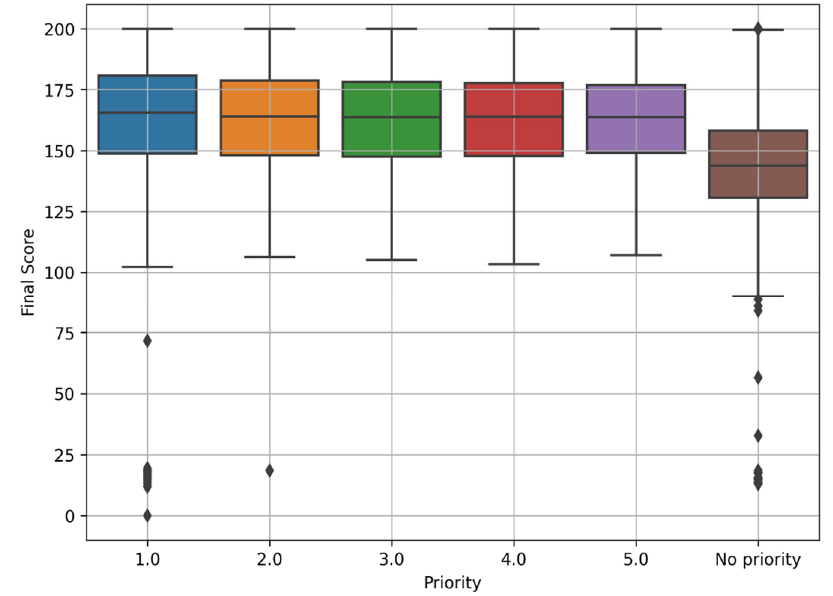
Figure 8. Final score box plot by admission priority.